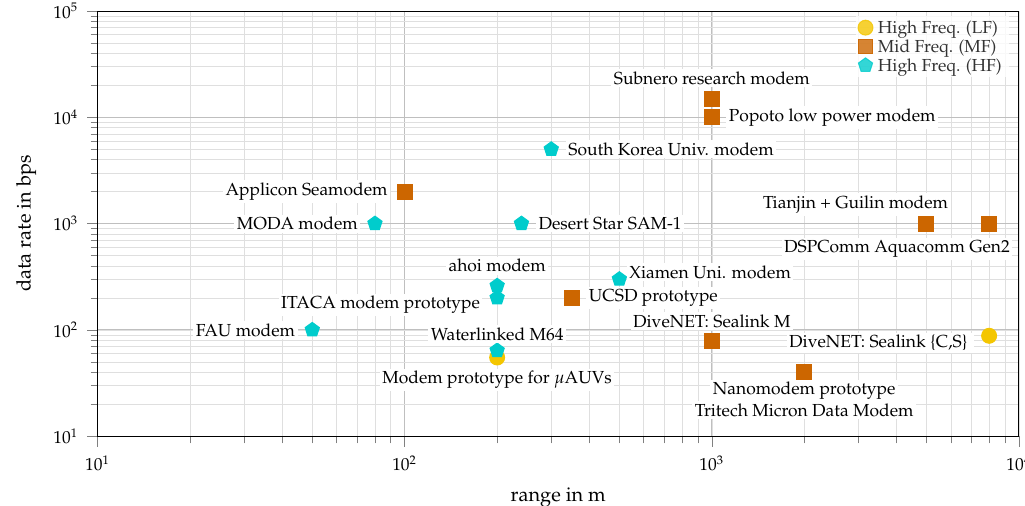
Figure 4. Range vs. data rate of recent low-cost acoustic underwater